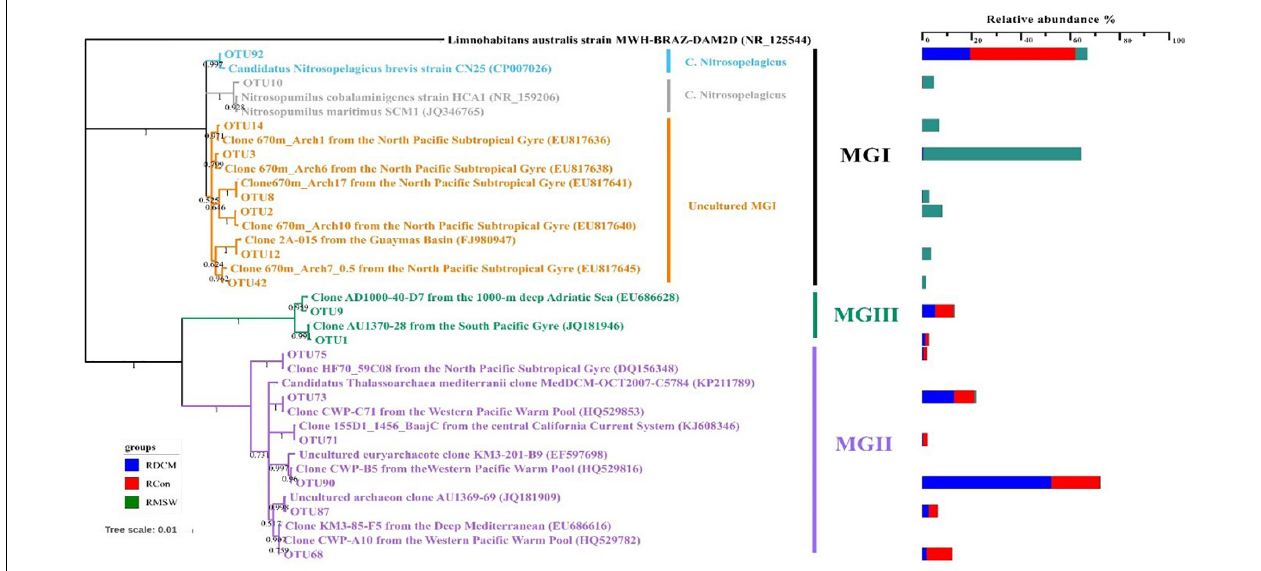
FIGURE 6 | Neighbor-joining phylogenetic tree based on 16S rRNA gene sequences of the representative OTUs based on 16S rRNA gene sequences from NCBI GenBank. These OTUs were those that made up more than 1% of the reads from at least a single sample. The scale bar represents the estimated number of nucleotide changes per sequence position. Percentage on nodes refer to the percentage of recovery from 1000 bootstrap resamplings. Only values > 50% are shown. Limnohabitans australis strain MWH-BRAZ-DAM2D (NR_125544) was used as the outgroup. The color bar represents the percentage composition of reads in an RNA